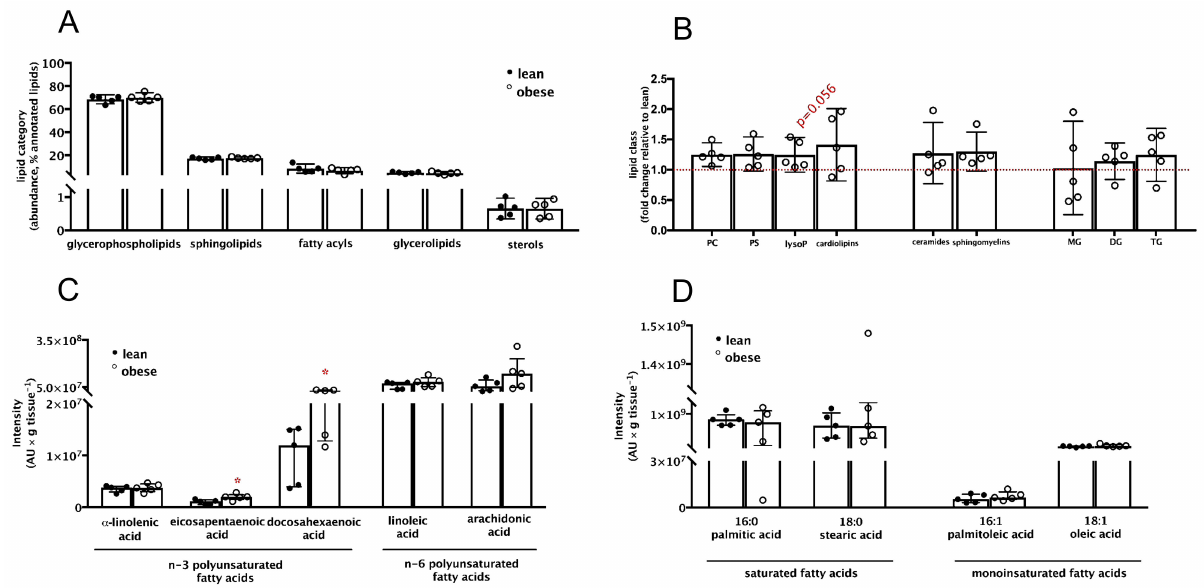
Figure 1. Placental lipid profile suggests alterations in long-chain polyunsaturated free fatty acids abundance in maternal pre-gestational obesity. Placental lipid profile was determined by IM-QTOF LC/MS after lipid extraction by the Folch method. Ion intensities were processed using a KNIME pipeline comprising both KNIME native nodes and integrated R scripts, and lipids were assigned into categories, classes, and species. Placentas from lean ( • ) and from obese ( were compared according to ( A ) the abundance of lipid categories expressed relative to total lipid annotated; ( B ) the major lipid classes in each category; and ( C ) the annotated polyunsaturated and ( D ) saturated and monounsaturated fatty acid species. PC: phosphatidylcholine; PS: phosphatidylethanolamine; lysoP: lysophospholipids; MG: monoacyglycerols;